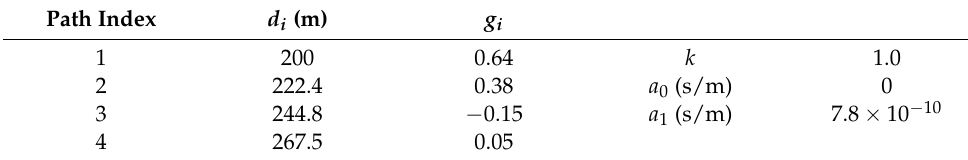
Table 2. PLC channel parameter profile.